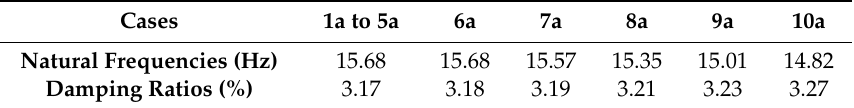
Table 8. Natural frequencies and damping ratios.